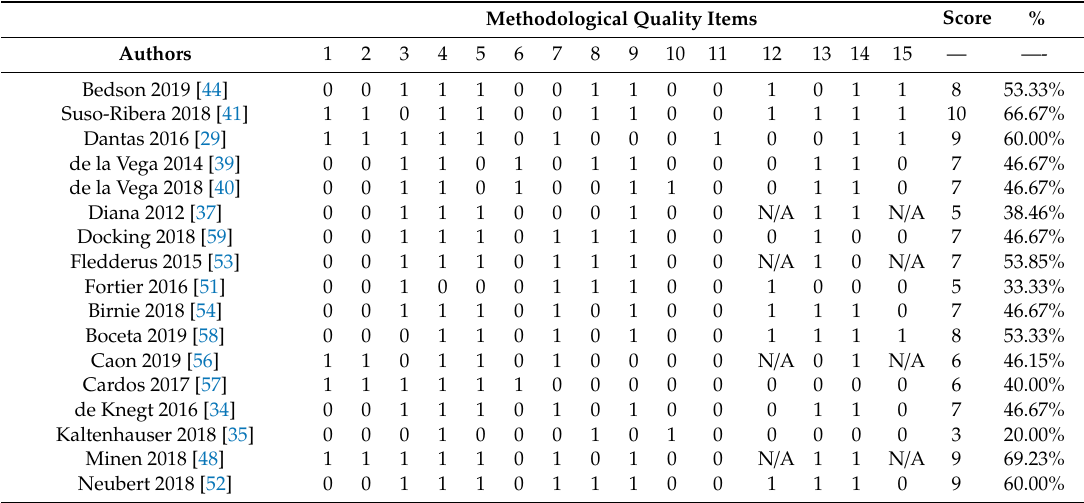
Table 2. Methodological quality assessment of studies included in the systematic